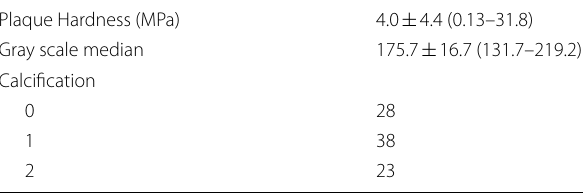
"0" was no calcification, "1" was scattered microcalcification, and "2" was calcification of 1 mm or more or the presence of microcalcification of 2%